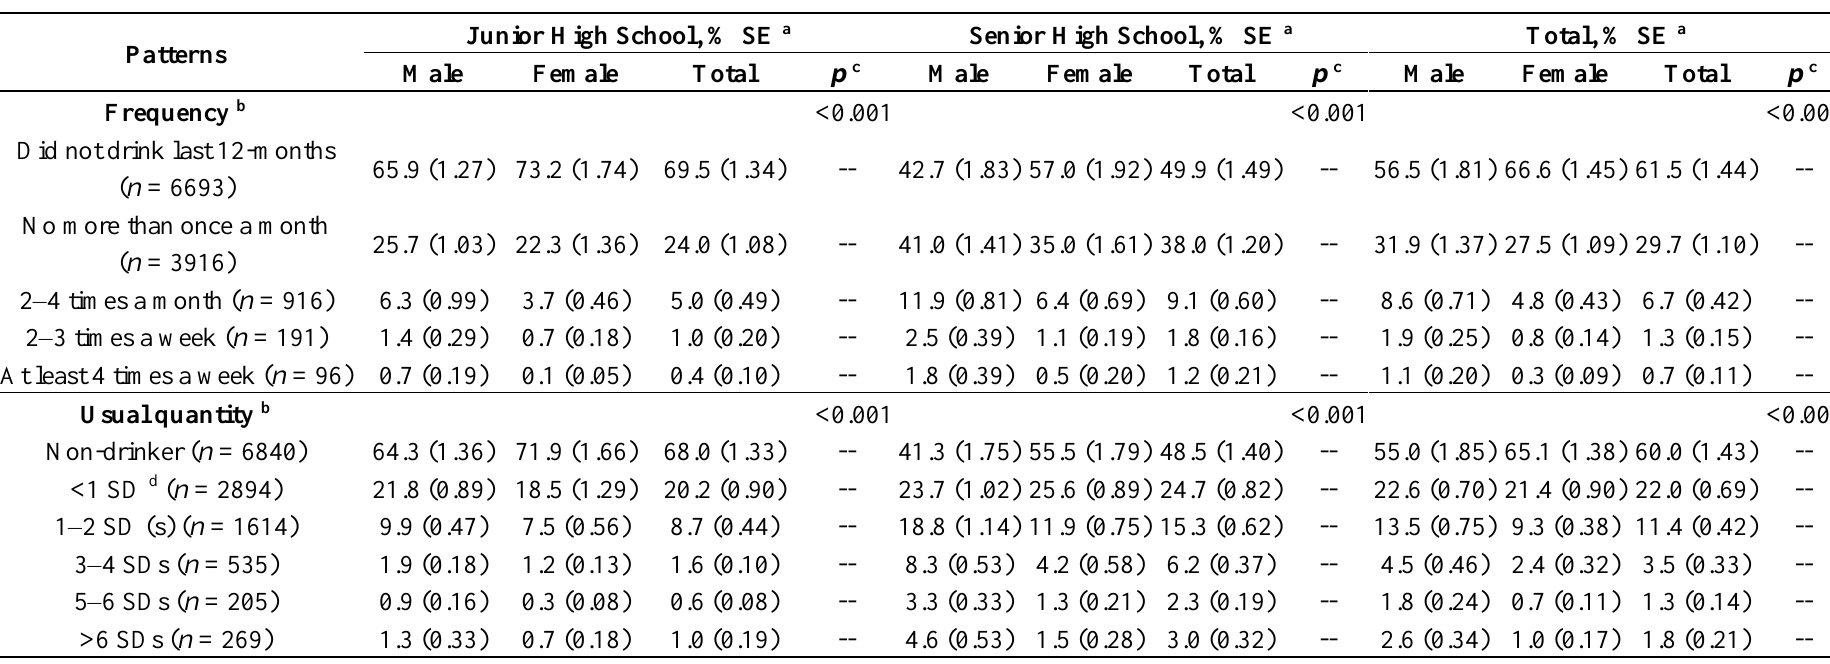
a Based on the weighted data. b Indicates the total number of drinking students of that category. c Rao–Scott Chi-square tests were performed to examine the differences of the whole group. d One SD contains 10 grams of pure